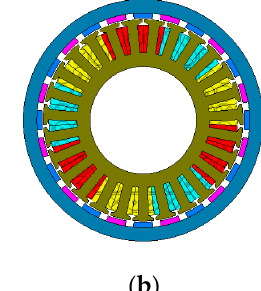
Figure 3. Finite element models of DDPMM: ( a ) DDPMM with open slots; ( b ) DDPMM with closed slots. Table 1. Main parameters of the DDPMM.